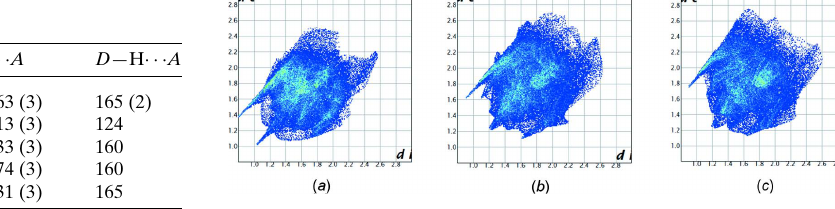
Figure 5 Two-dimensional fingerprint plots for the cation in the three salts under study: ( a ) AmCl , ( b ) AmBr and ( c ) AmI .